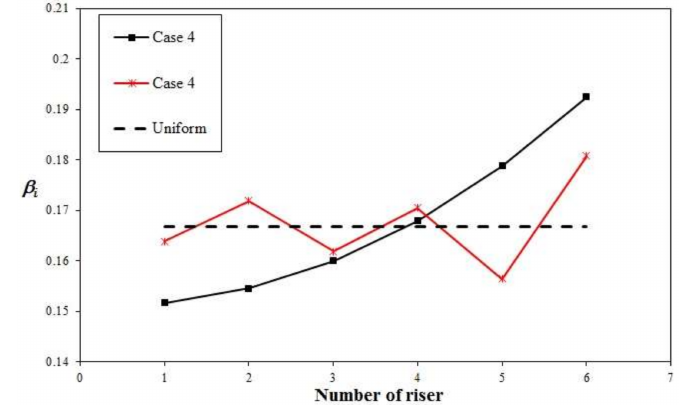
Figure 11. Average velocity in riser tubes at different volumetric flow rates. Flow distribution comparison between Case 0 and Case 4 at 6 L/min.